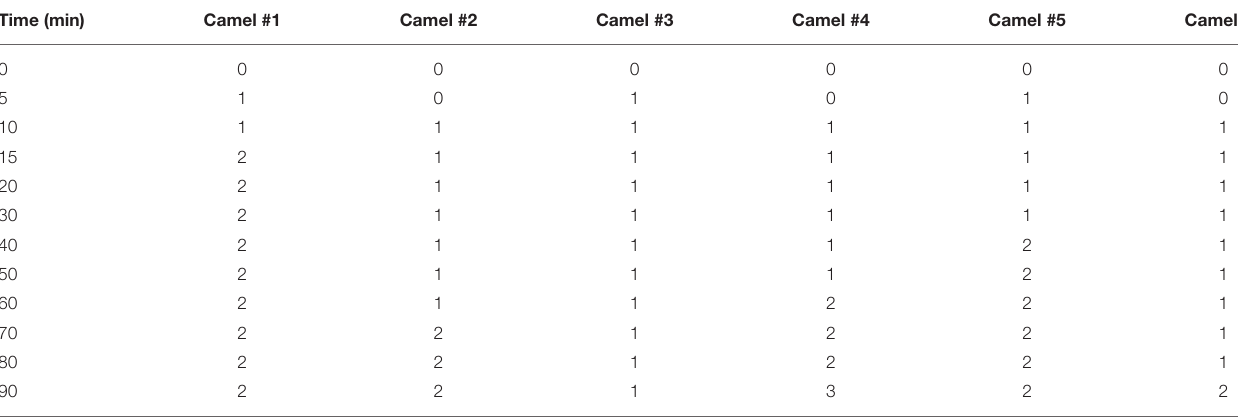
TABLE 2 | The sedation scores after acepromazine (0.1 mg/kg) intravenous administration in dromedary camels ( n = 6). Time (min) Camel #1